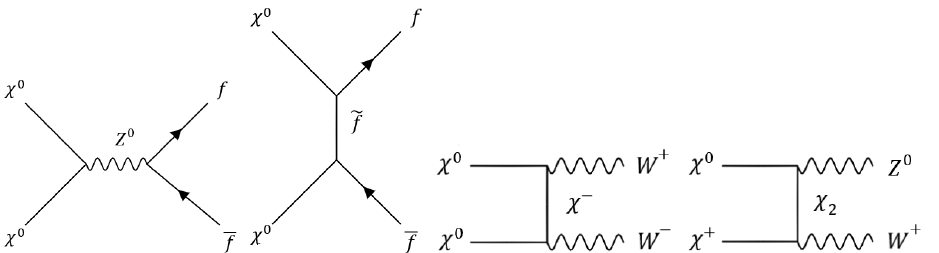
Figure 1. Left to right: Annihilation to fermion-antifermion pairs via Z 0 exchange, and sfermion exchange, occurs for neutralinos but not higgsons. (These left two figures follow Ref. [41], retaining the same conventions.) Annihilation to W + W − pairs via χ ± exchange, and coannihilation to Z 0 W + via χ 2 exchange, occur for neutralinos but not higgons. (These right two figures follow Ref. [32], retaining the same conventions.)